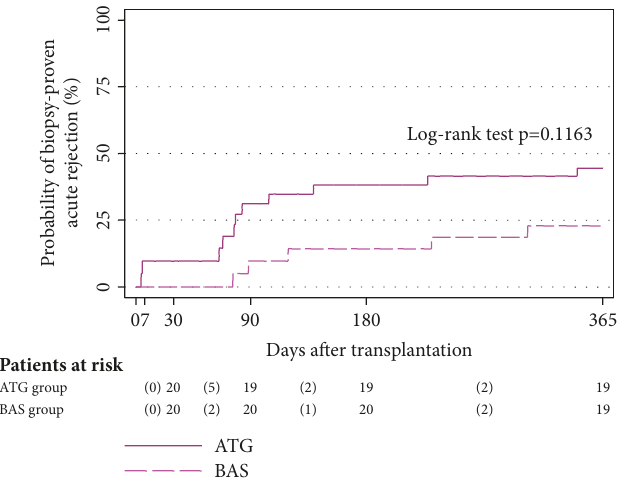
Figure 3: Cumulative probability of biopsy-proven rejection after